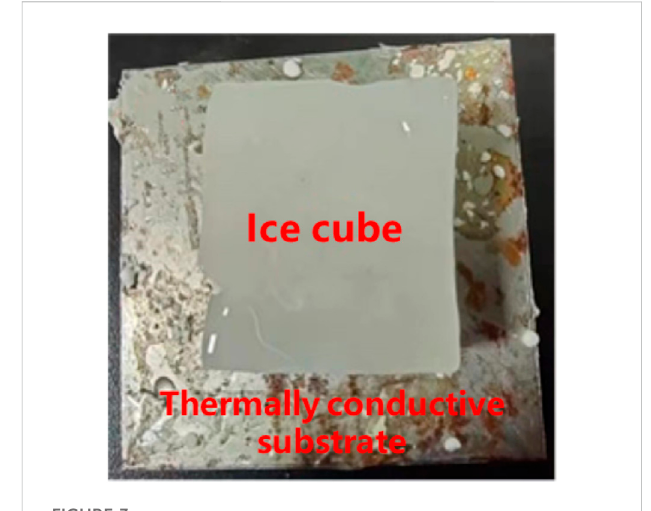
FIGURE 3 As-prepared complete ice cube